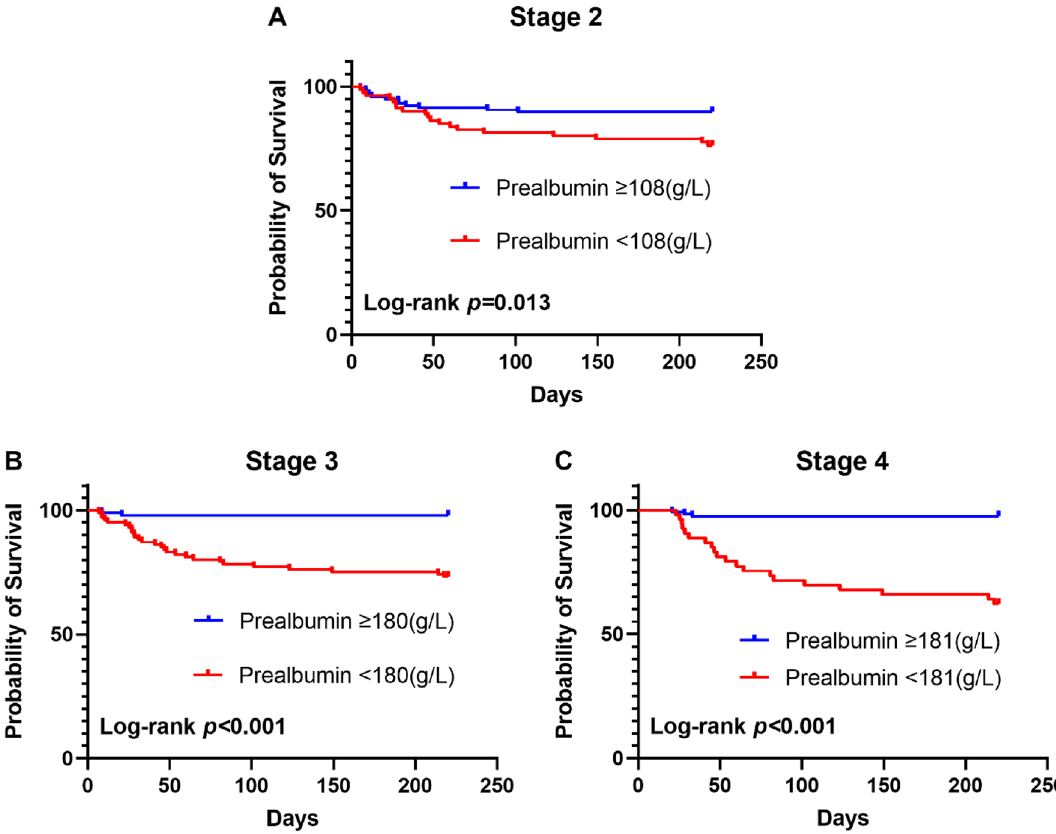
Figure 5. Kaplan–Meier 240-day survival between prealbumin target and non-target groups at different stages in patients with severe acute